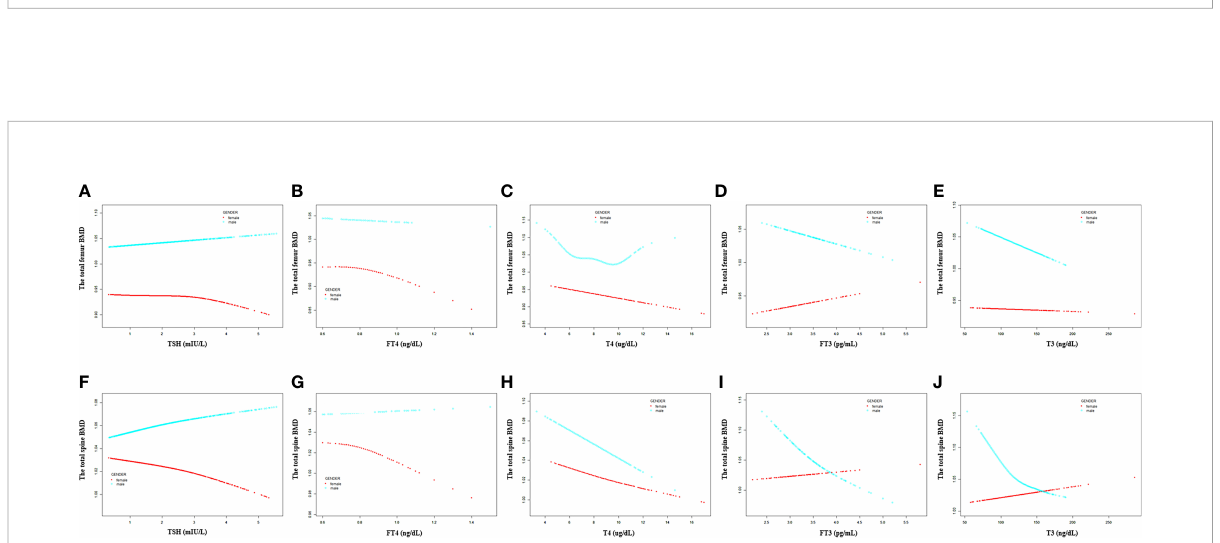
FIGURE 3 Association between the thyroid hormone pro fi le and BMD strati fi ed by gender. (A – E) TSH, FT4, T4, FT3, and T3 with the total femur BMD. (F – J) TSH, FT4, T4, FT3, and T3 with the total spine BMD. Solid rad line represents the smooth curve fi t between variables. Blue bands represent the 95% con fi dence interval from the fi t. Gender, age, education, race, ratio of family income to poverty, hypertension, diabetes, BMI, smoking status, alcohol intake, serum creatine, serum triglyceride, serum total calcium, ALP, and AST were